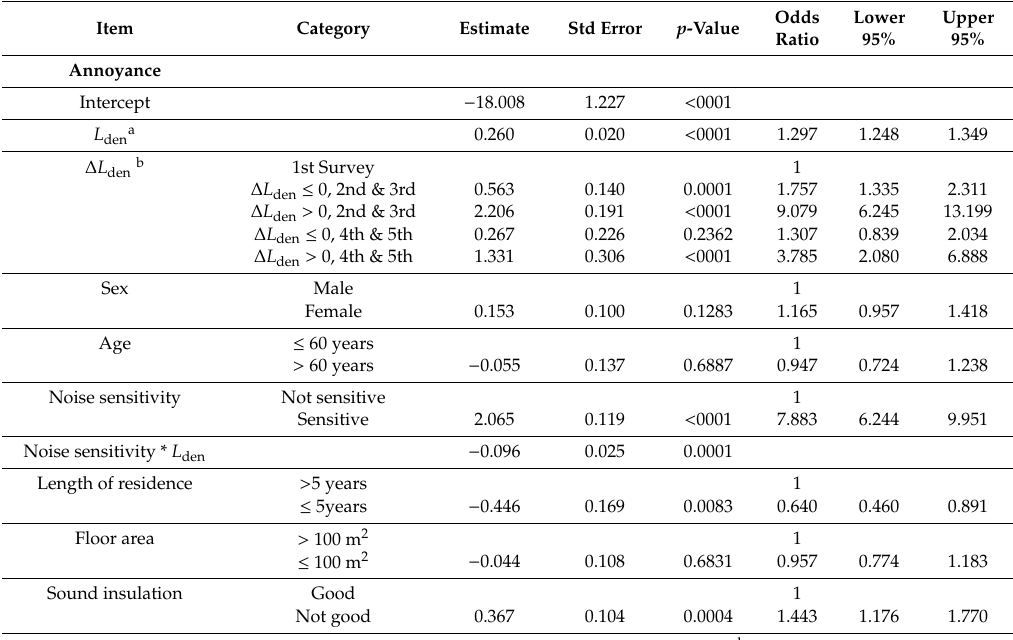
Table 7. Multiple logistic regression for annoyance (Generalized R 2 : 0.3632; AUC (Area under the curve):